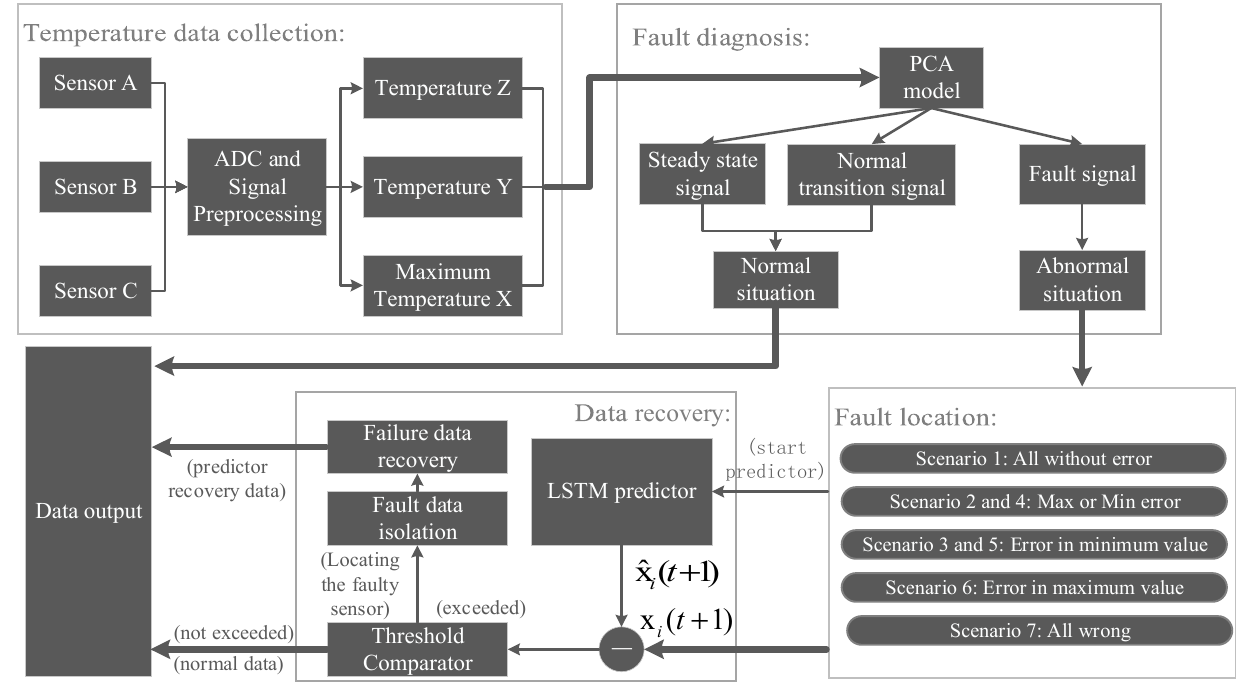
Figure 4. The sensor fault diagnosis and restoration algorithms.